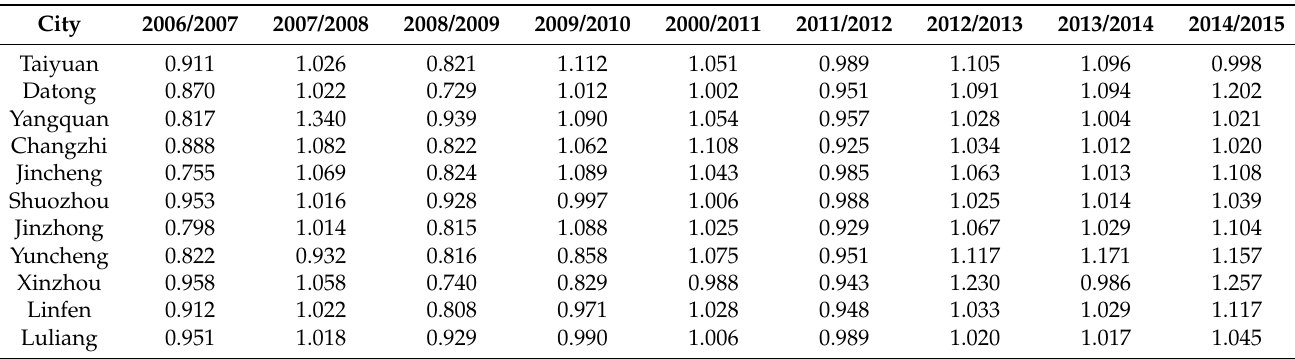
Table 4. The year-on-year technical efficiency change index for prefectural cities in Shanxi Province 2006–2015 (Bootstrap- Malmquist).